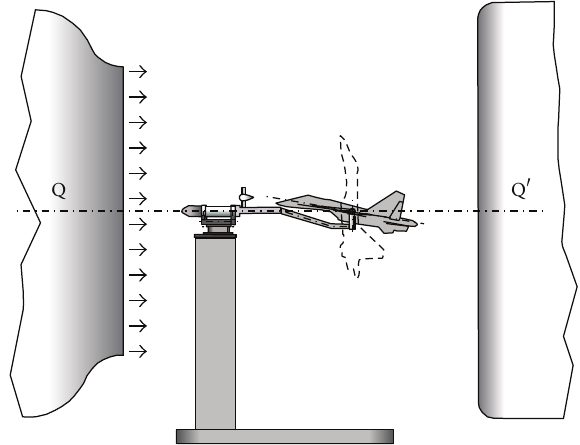
Figure 22: Three-degree-of-freedom rig for spin recovery investi- gation in the SibNIA T-203 wind tunnel